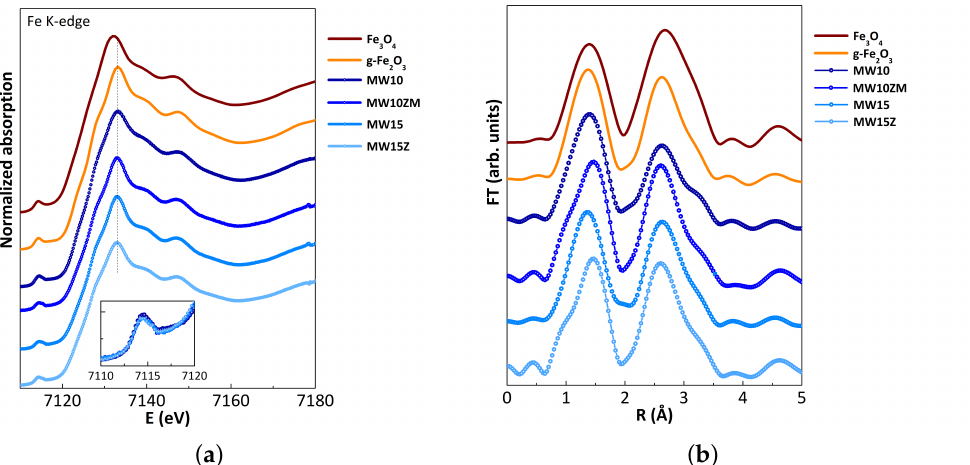
Figure 5. ( a ) Fe K-edge XANES spectra of synthesized samples and iron oxide references from bottom to top. Inset: pre-peak of synthesized samples. ( b ) Fourier transform of k 2 -weighted EXAFS signal of synthesized samples and iron oxide references (Fe 3 O 4 (magnetite) and γ -Fe 2 O 3